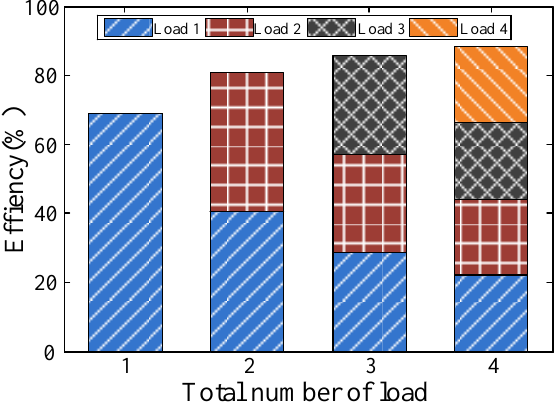
Figure 12. The efficiency stack graph of systems with different load numbers.